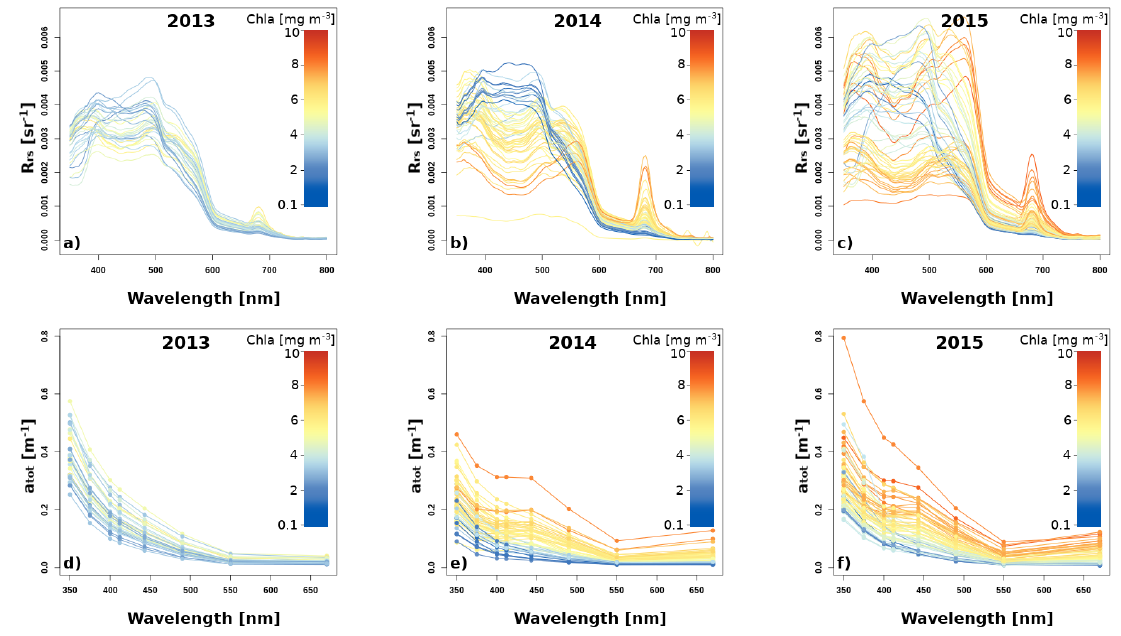
Figure 3. Remote sensing reflectance spectra ( a – c ) and total absorption coefficients ( d – f )